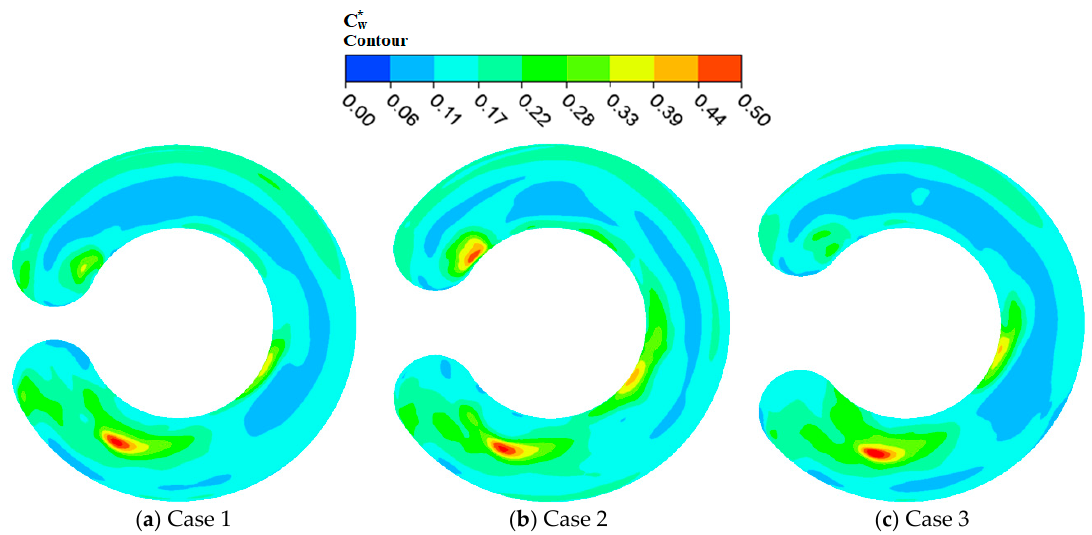
Figure 23. Velocity fluctuation intensity in side channel passage.